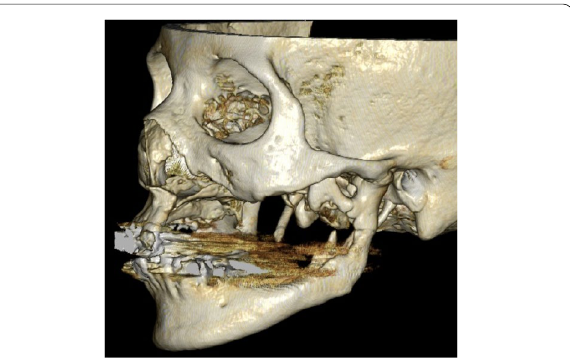
Fig. 3 Preoperative 3D CT imaging findings. CT revealed completely separated sequestrum and pathological hairline fractures